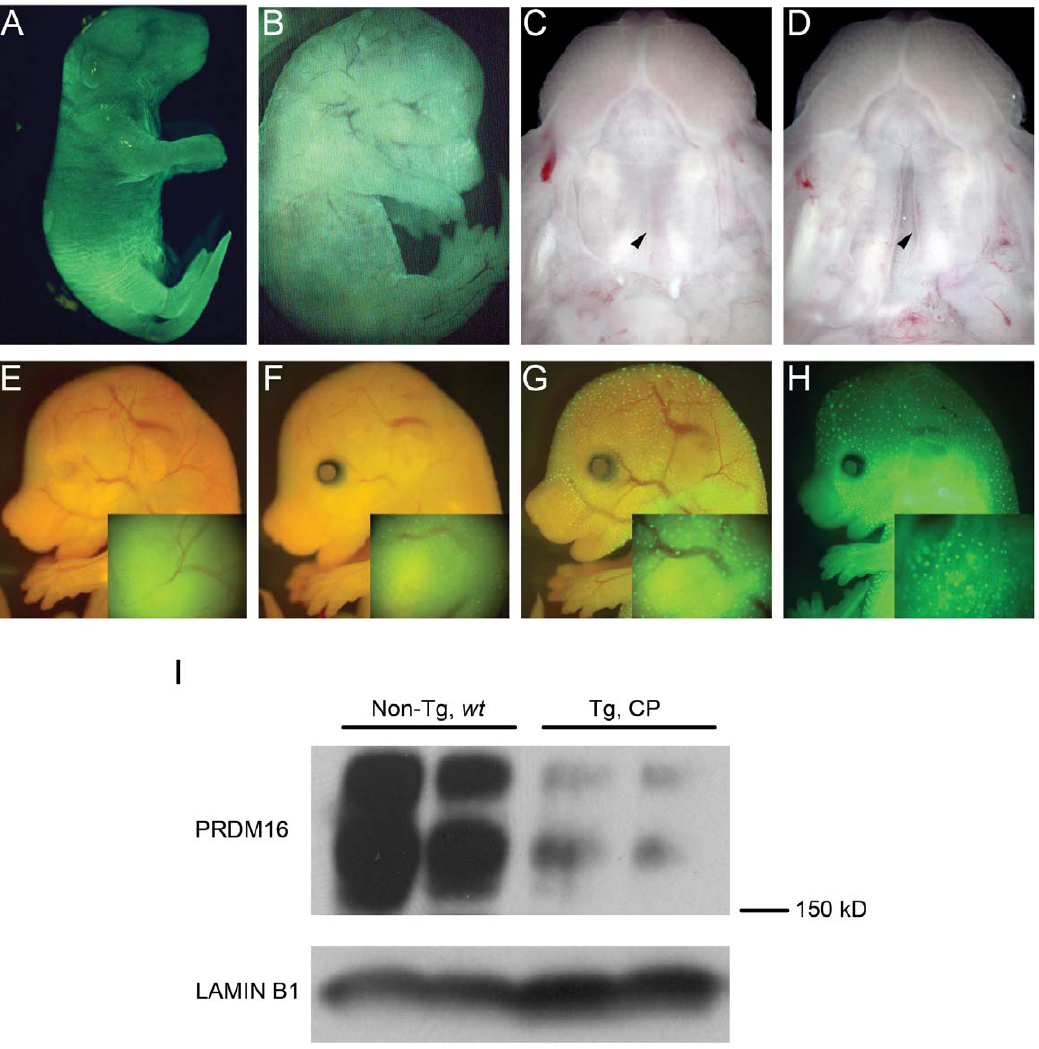
Figure 4. Transient transgenic RNAi knockdown of Prdm16 in mice recapitulates the recessive csp1 ENU mutant phenotype. A ) Strong GFP expression driven by the CMV-eGFP cassette with plasmid DNA injection of pLL3.7. B ) Similarly strong ubiquitous GFP expression visible in some lentivirus infected transient transgenic Prdm16 RNAi knock down E16.5 embryos. Wild-type ( C ) and transgenic ( D ) E16.5 embryos with fused and cleft palate, respectively, representative of the CP phenotype observed in affected transgenic embryos produced using delivery vehicles reported in this study. Variable GFP expression pattern observed in transgenic embryos carrying CpG-free SB transposons with the H1-GFP cassette, also representative of the variability of GFP expression pattern observed in all constructs utilizing a GFP expression cassette ( E–H ). Insets consist of higher magnification images taken of head regions from these same embryos. I ) Western blot analysis for PRDM16 in nuclear lysates isolated from non- transgenic wild type (Non-Tg, wt ) and transgenic CP E16.5 embryonic heads derived from pronuclear injection of a Prdm16 -specific shRNA-expressing PB transposon. LAMIN B1 expression is provided as a loading control.